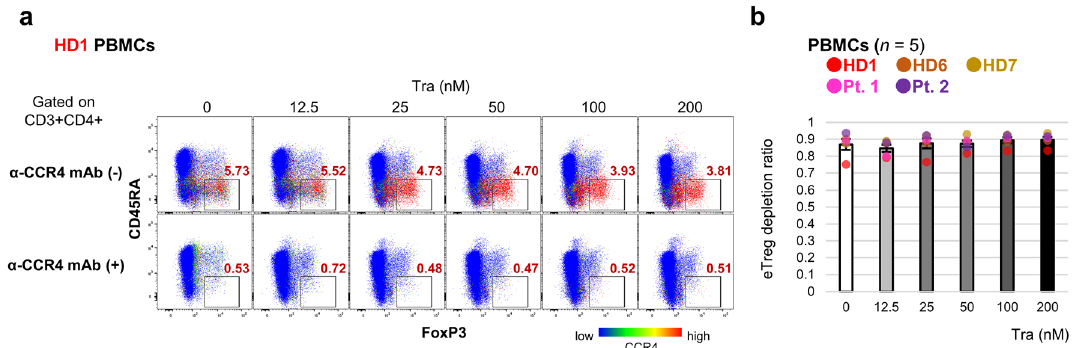
Figure 6. Trametinib did not affect eTreg depletion by anti-CCR4 mAb. PBMCs were incubated with 0.1 μg/mL KM2760 for 7 days and subjected to flow cytometry. CD45RA and FoxP3 expression in CD4 + T-cells is shown with a representative, and the intensity of CCR4 expression is presented in the heat map ( a ). The percentage of eTregs indicated by CD4 + CD45RA - FoxP3 high is displayed in the figure. The depletion ratio of eTregs in the KM2760 group is shown with a summary of the result ( n = 5, independent donors) ( b ). Error bars indicate standard